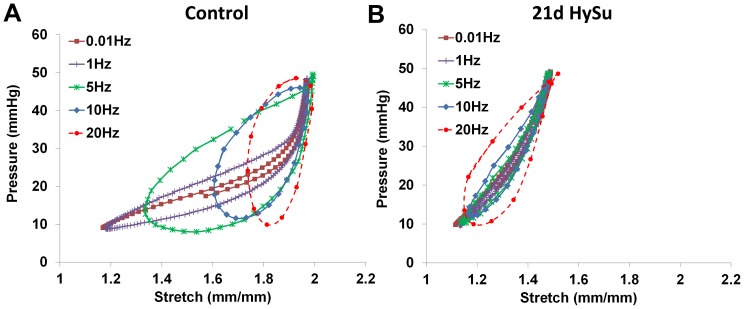
Examples of pressure-stretch curves obtained from control (A) and 21d HySu (B) PAs.